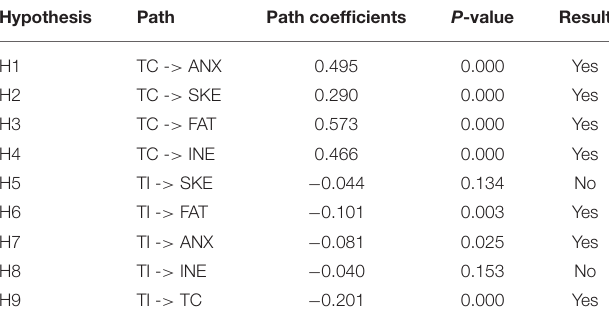
TABLE 6 | Structural model evaluation results.